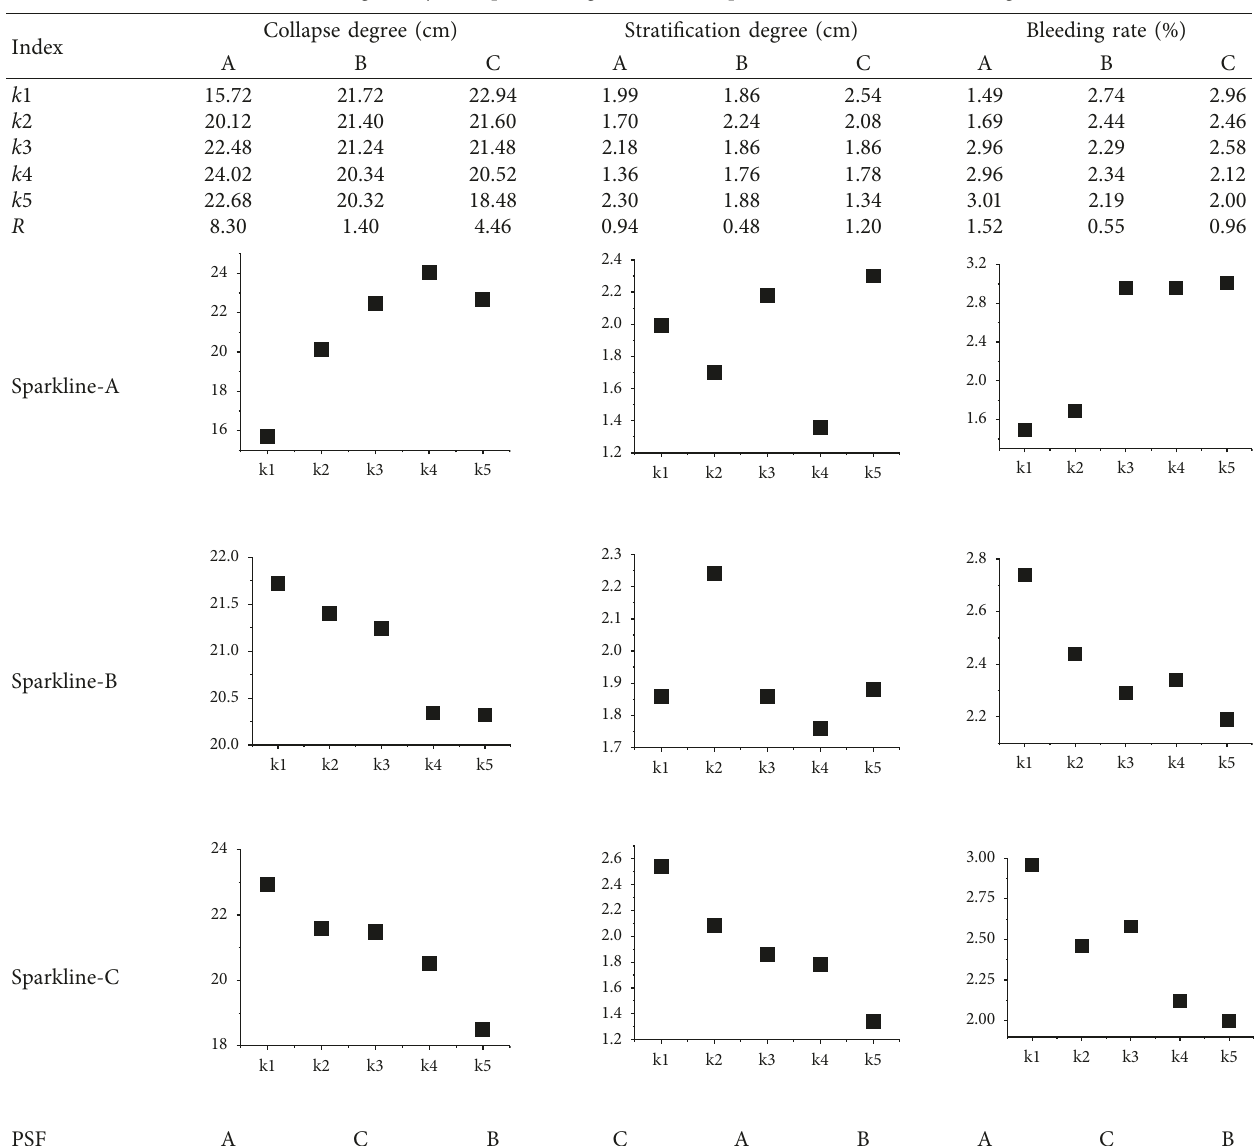
Table 3: Range analysis of paste filling material collapse, stratification, and